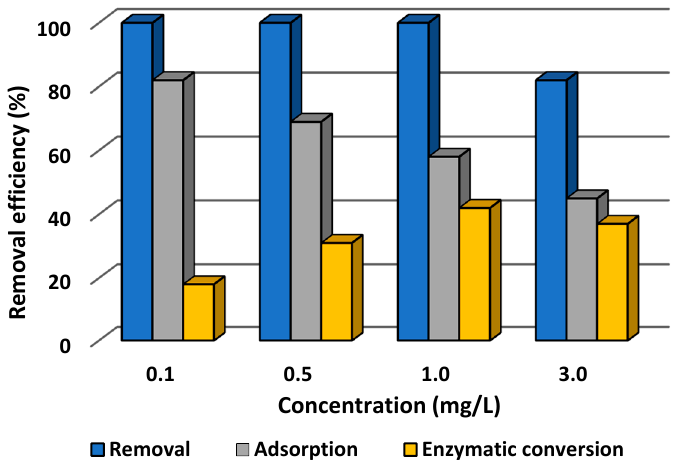
Figure 6. Effect of initial concentration of tetracycline solution on the efficiency of its adsorption, enzymatic conversion, and total removal by laccase immobilized on a chitin scaffold. The error value in each of the experiments (based on the mean and standard deviation from three experiments) does not exceed 3.5%. Adsorption efficiency denotes the efficiency of adsorption by the chitinous scaffold with immobilized laccase following thermal inactivation.